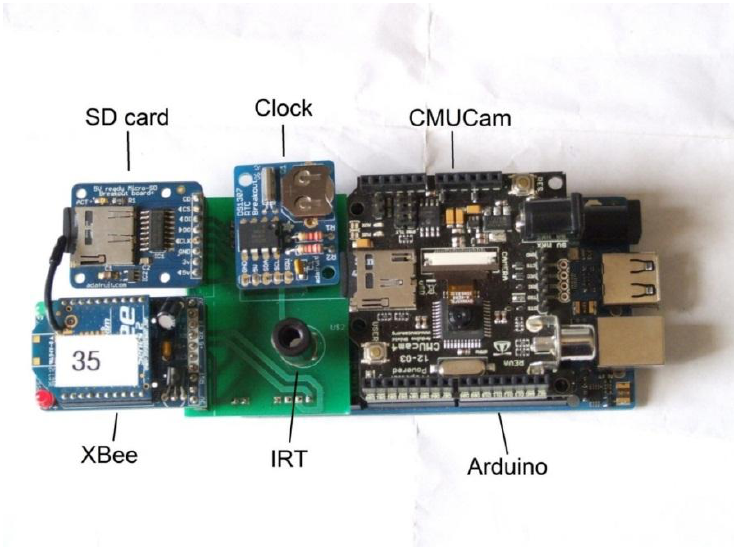
Figure 3. Wireless computer vision